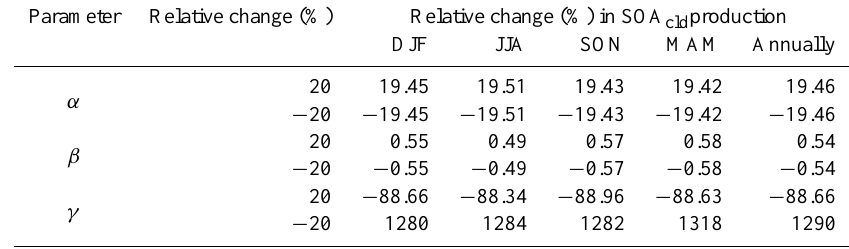
Table 3. The relative change in SOA cld production as a 20% increase/decrease of each parameter in Eq. (2).